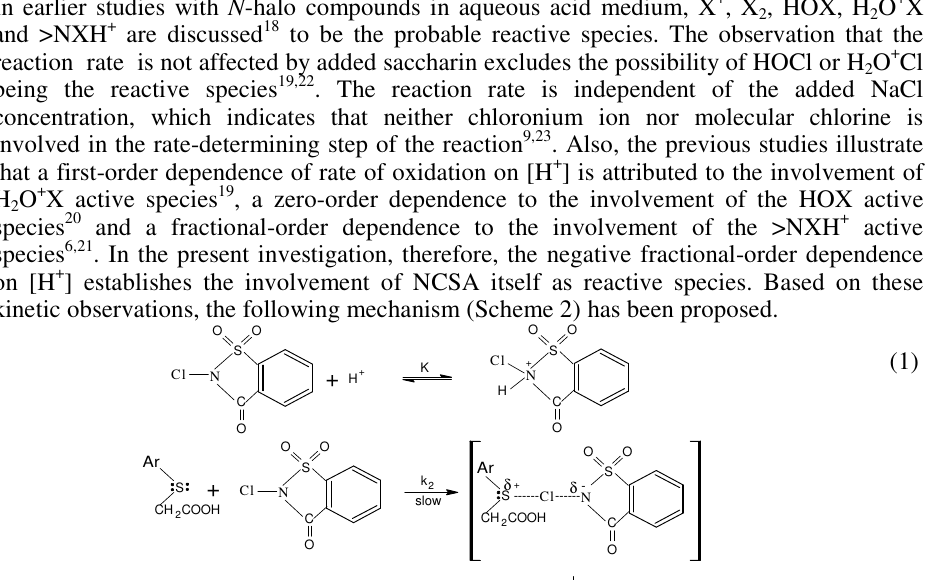
Figure 4. Hammett plot for the oxidation of ( p -substituted phenylthio)acetic acids by NCSA at 298 K